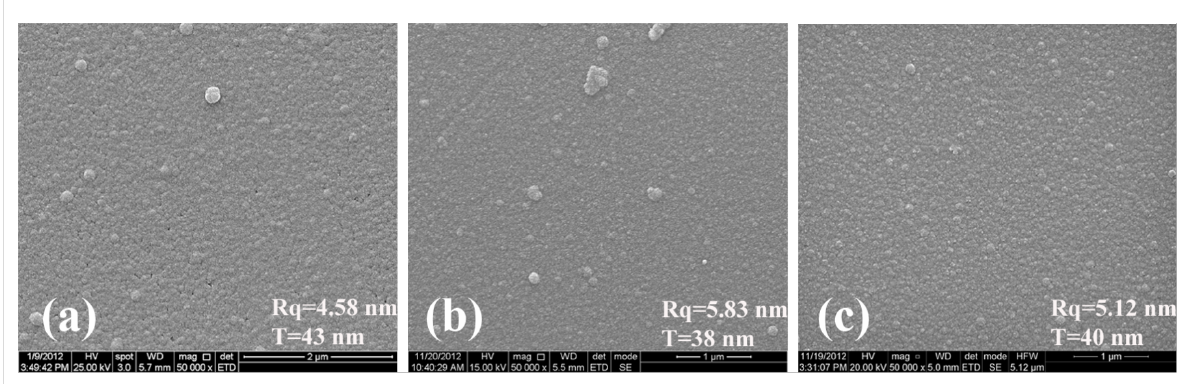
Figure 2: SEM images of titania coating on a) Si, b) kapton and c) PDMS. rms roughness measured by AFM and thickness by